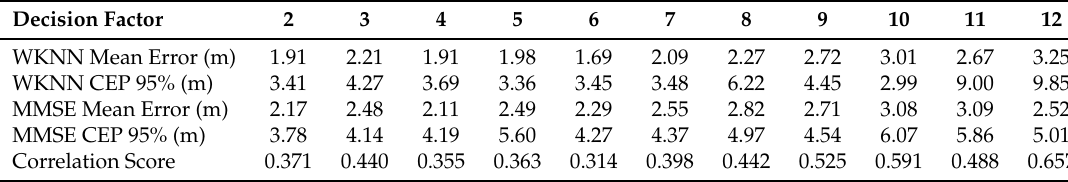
Table 3. Localization algorithm performance and correlation score per candidate radiomap.